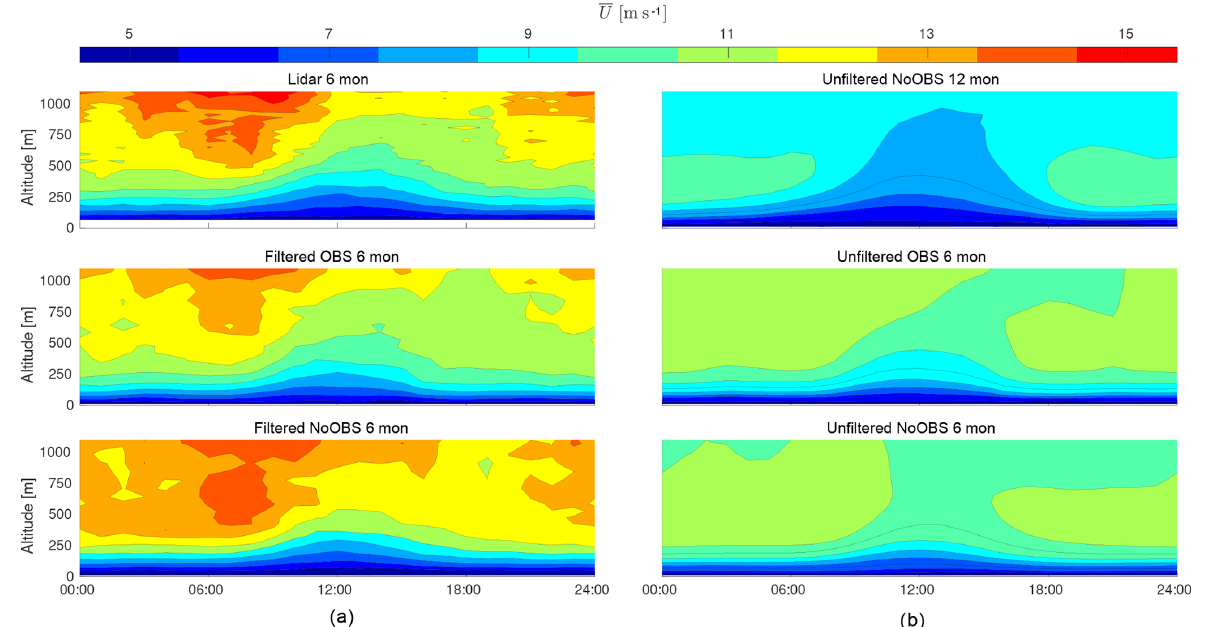
Figure 6. Hourly average diurnal variation of measured and modeled horizontal wind speed U filtered by lidar availability (a) and unfil- tered (b) .